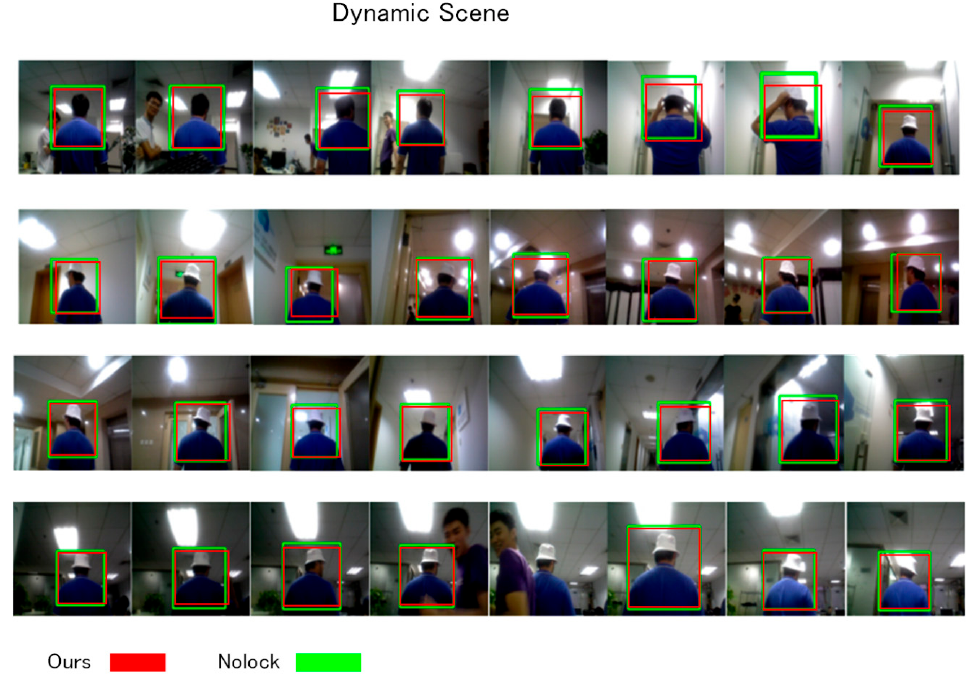
Figure 9. Image sequence for the dynamic situation.